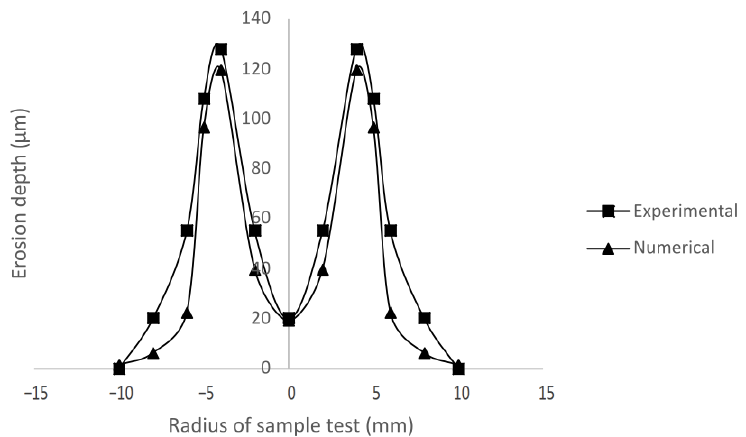
Figure 6. Numerical and experimental material removal in the test specimen (5 min